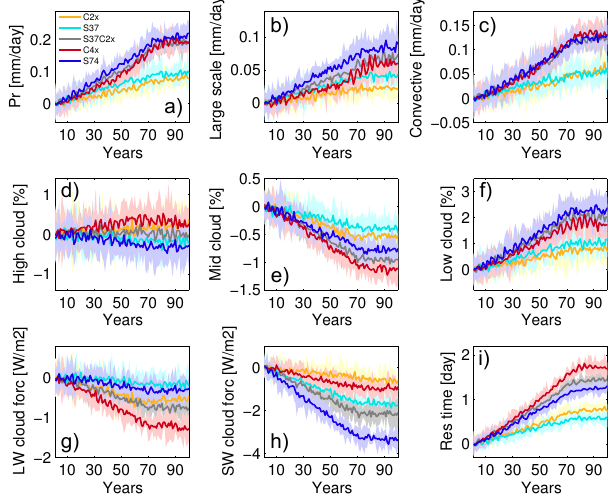
Fig. 3. Global annual mean anomalies of selected components of the hydrological cycle. Averages over five ensemble members are shown and shading extends from the lowest to the largest value obtained by any of the five ensemble members. (a) total precipita- tion [mmday − 1 ], (b) large-scale precipitation [mmday − 1 ], (c) con- vective precipitation [mmday − 1 ], (d) high cloud fraction [%], (e) mid-level cloud fraction [%], (f) low cloud fraction [%], (g) long- wave cloud radiative forcing [Wm − 2 ], (h) shortwave cloud radia- tive forcing [Wm − 2 ] and (i) residence time